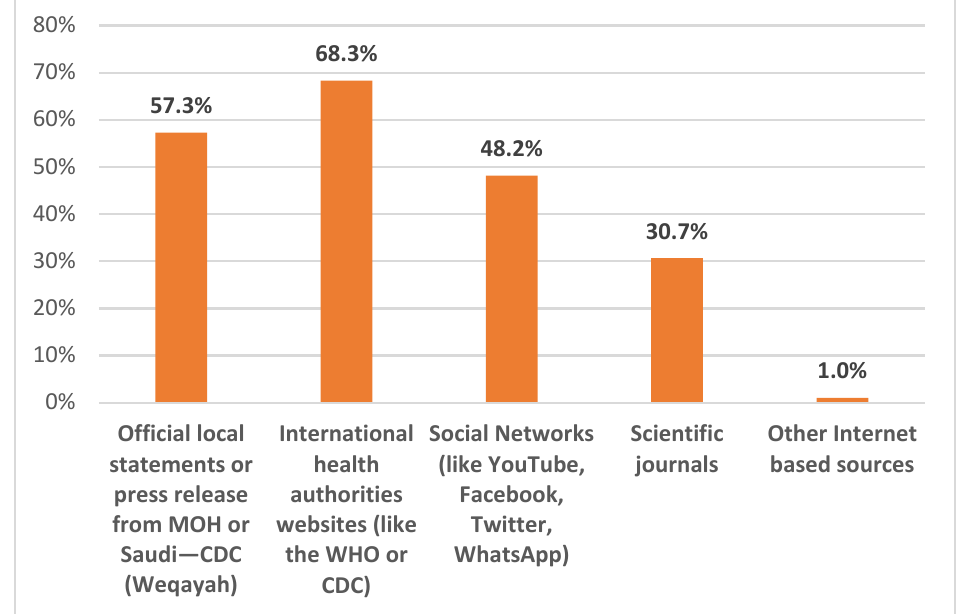
Figure 5. Participants’ sources of information about Mpox disease.